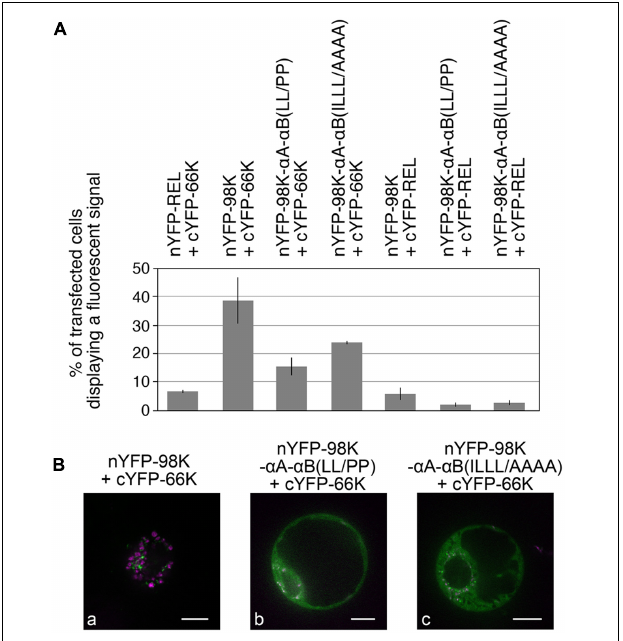
FIGURE 9 | Impact of the structure and amphipathic property of CTD α -helices on the ability of 98K to interact with 66K as determined by bimolecular fluorescence complementation. (A) Arabidopsis protoplasts were cotransfected with the expression plasmids as indicated, together with p (cid:127) -RbCS-NiRFP. Cells were collected 40 hpt and the percentage of cells displaying a fluorescent YFP signal was determined by flow-cytometry. Values were normalized to the percentage of transfected cells and are represented as the mean ± SD of three independent experiments. (B) Single protoplasts were observed by spinning-disk confocal laser microscopy (SPCLM) 48 hpt and YFP localization was observed (green). To visualize the localization of chloroplasts, NiRFP fluorescence and chlorophyll autofluorescence were acquired (magenta) and superimposed onto the YFP fluorescence. Scale bars, 10 µ